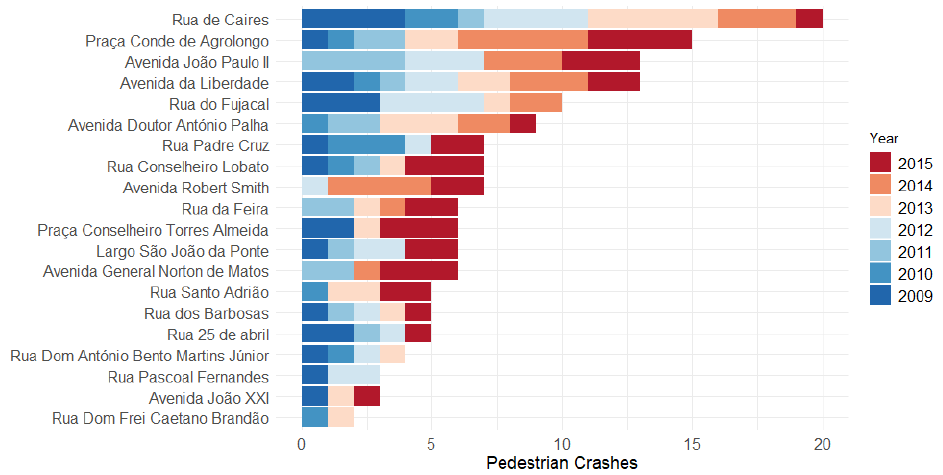
Figure 3. The number of pedestrian crashes per road and year in Braga.